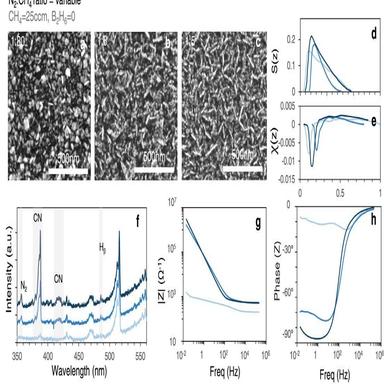
(a–c) SEM, (d,e) MFs, (f) optical emission spectra of the C/N/H plasma, (g,h) EIS Bode plot of three samples grown at a variable N2/CH4 ratio.